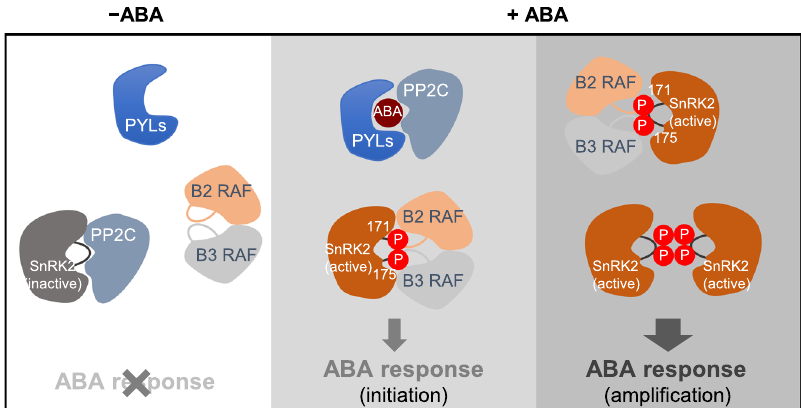
Fig. 7 A model illustrating the role of B2 and B3 RAFs in ABA signaling in Arabidopsis. Under unstressed conditions, PP2C binds to and inhibits SnRK2 protein to prevent the transphosphorylation by activated RAFs (left panel). In the presence of ABA, ABA receptor PYR/PYL/RCARs (PYL) complex binds to and inhibits PP2C and SnRK2 is released from PP2C-mediated inhibition. SnRK2 can then be quickly activated by RAFs. In the meantime, stress also activates RAFs by an unknown mechanism (middle panel). The activated SnRK2 can quickly trans-phosphorylate more SnRK2 proteins to amplify the activation and phosphorylate downstream substrates to mediate stress responses (right